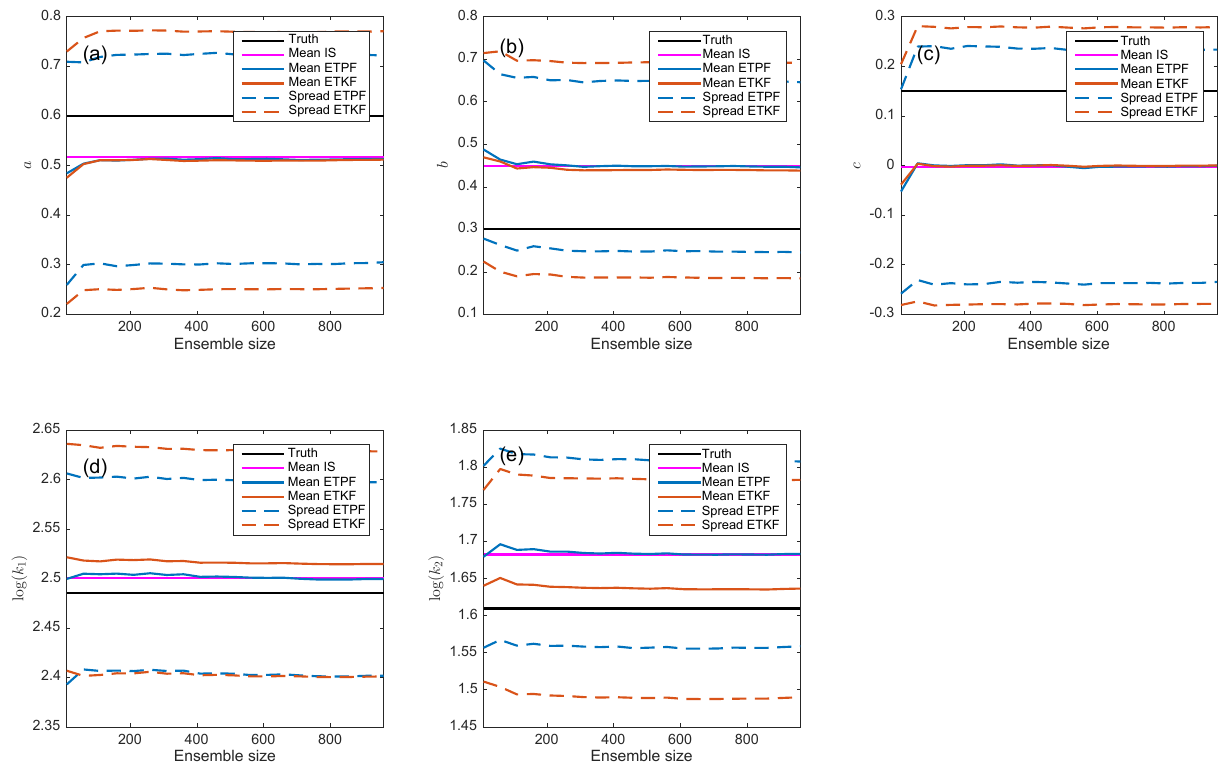
Figure 4. ¯¯ u a and ¯¯ u a ± ¯ u a w.r.t. ensemble size: (a) for the parameter a , (b) for b , (c) for c , (d) for log (k 1 ) , and (e) for log (k 2 ) . ETPF is std shown in blue, ETKF in red, the true parameters in black, and the mean of IS in